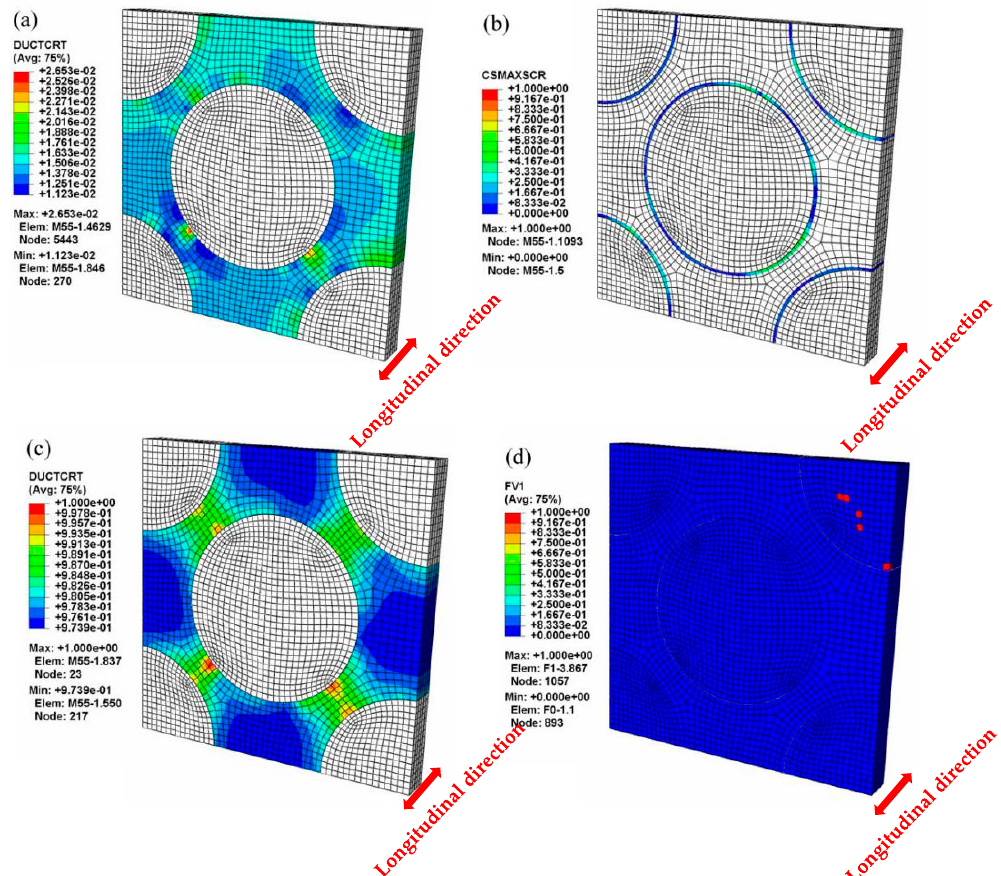
Figure 11. Microscopic damage and failure in the longitudinal tensile process (MFEA-A). ( a ) Matrix damage initiation ( ε L = 0.13%); ( b ) local interface failure ( ε L = 0.39%); ( c ) local matrix failure ( ε L = 0.40%); ( d ) local fiber facture ( ε L = 0.46%).